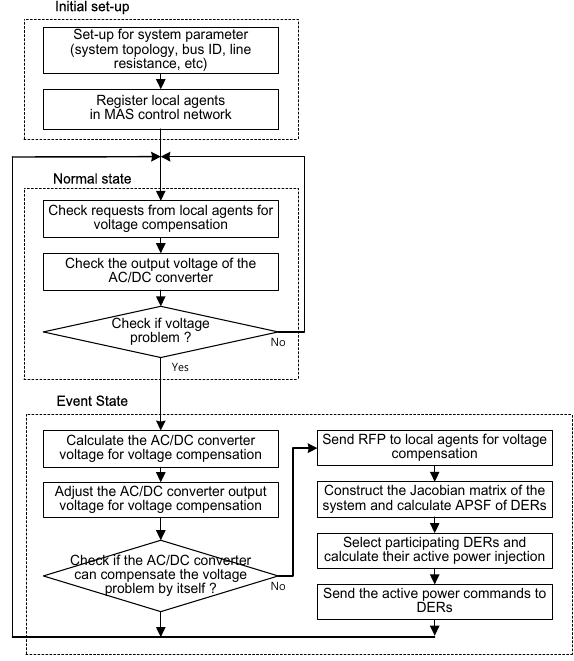
Figure 8. Flow-chart of decision-making procedure of the master agent.